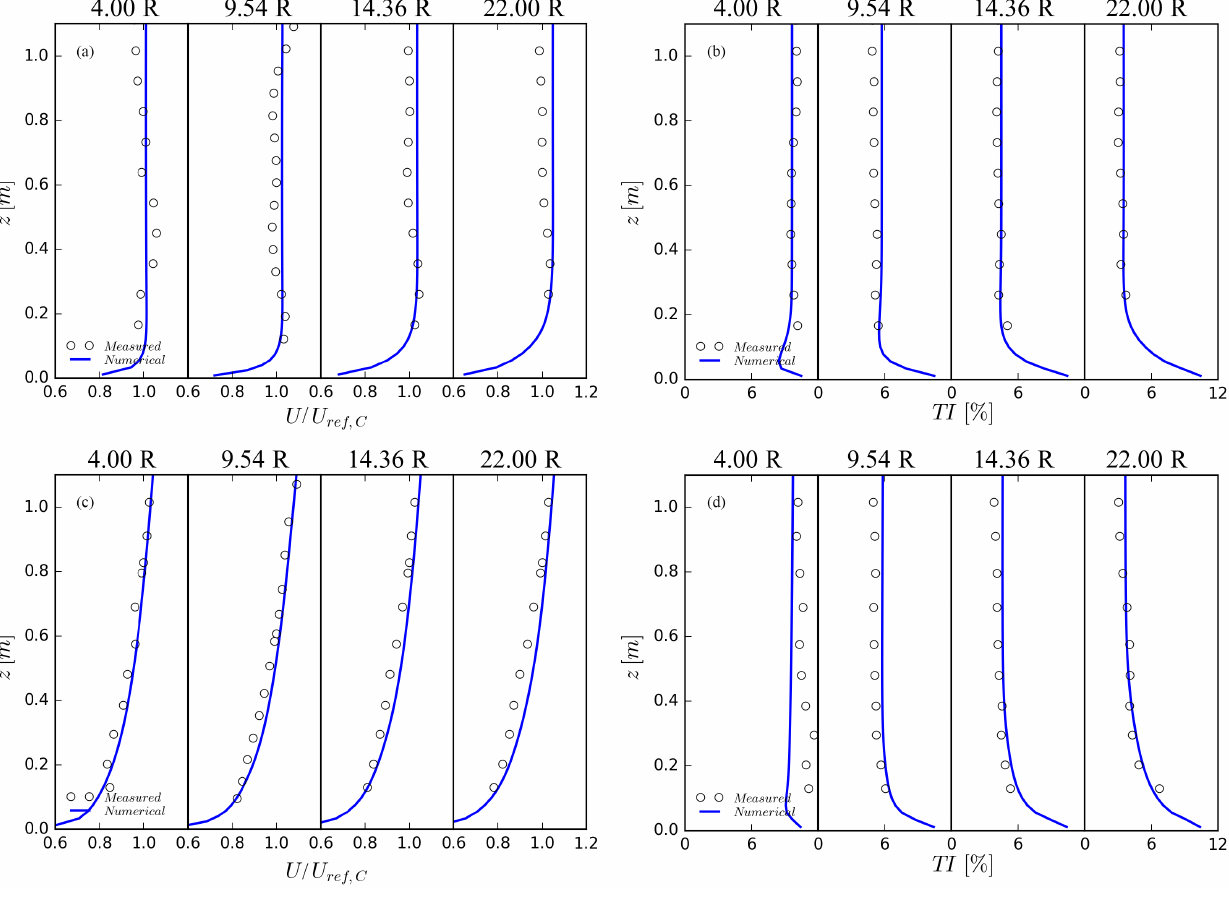
Figure 10. Empty-domain stream-wise velocity and turbulence intensity results for case C1 (a, b) and case C2 (c, d) for four vertical profiles downstream of the inlet when using the k - ε turbulence model.